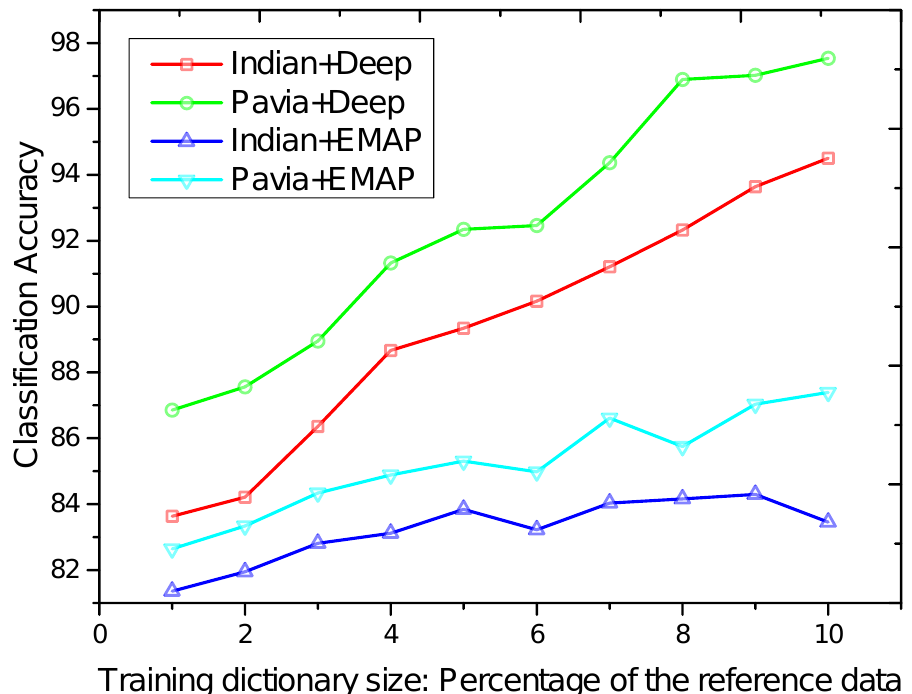
Figure 7. Classification OAs as a function of training dictionary size (expressed as a percentage of training samples for each class) for the Indian Pines and Pavia University